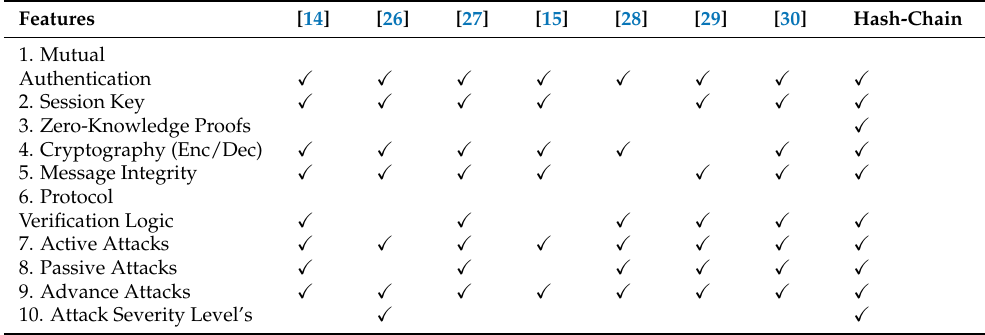
Table 5. Comparison of protocol